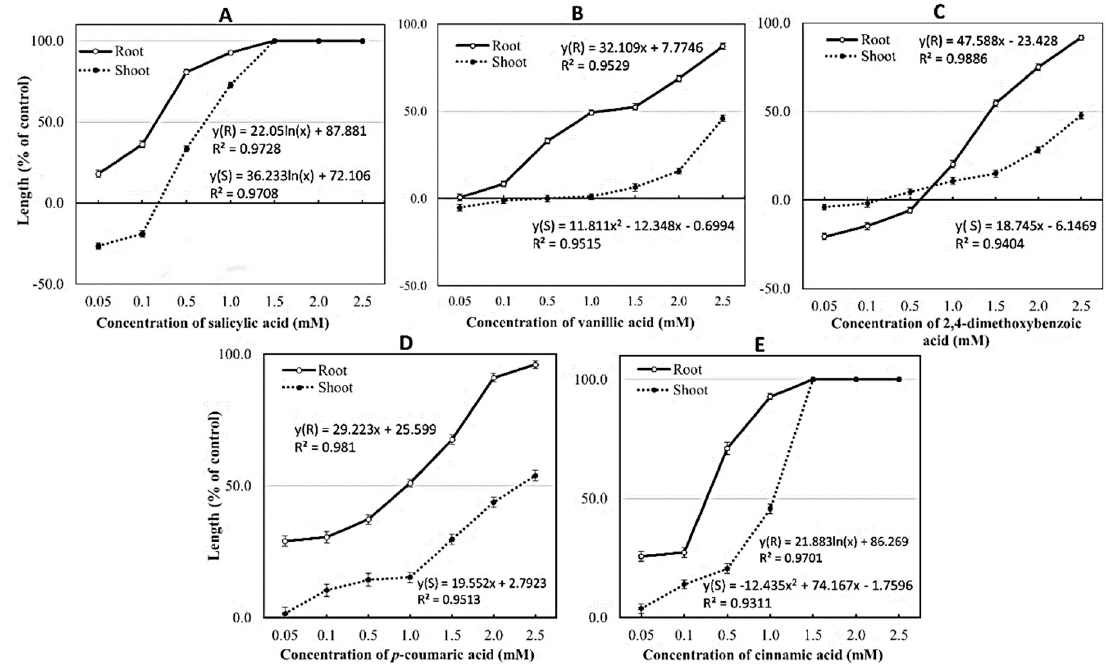
Figure 5. Effect of five allelochemicals confirmed in OM 5930 rice cultivar on the shoot and root growth of mustard green at concentrations of 0.05, 0.1, 0.5, 1.0, 1.5, 2.0, and 2.5 mM. ( A ) salicylic acid, ( B ) vanillic acid, ( C ) 2,4-dimethoxybenzoic acid, ( D ) p- coumaric acid, and ( E ) cinnamic acid.